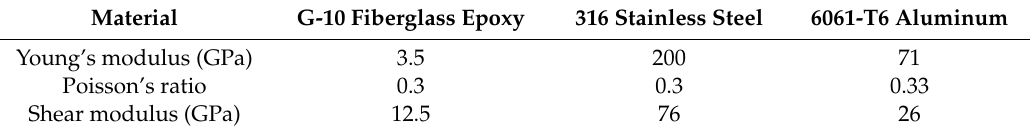
Table 3. Elastic properties of materials used in the structural simulation.